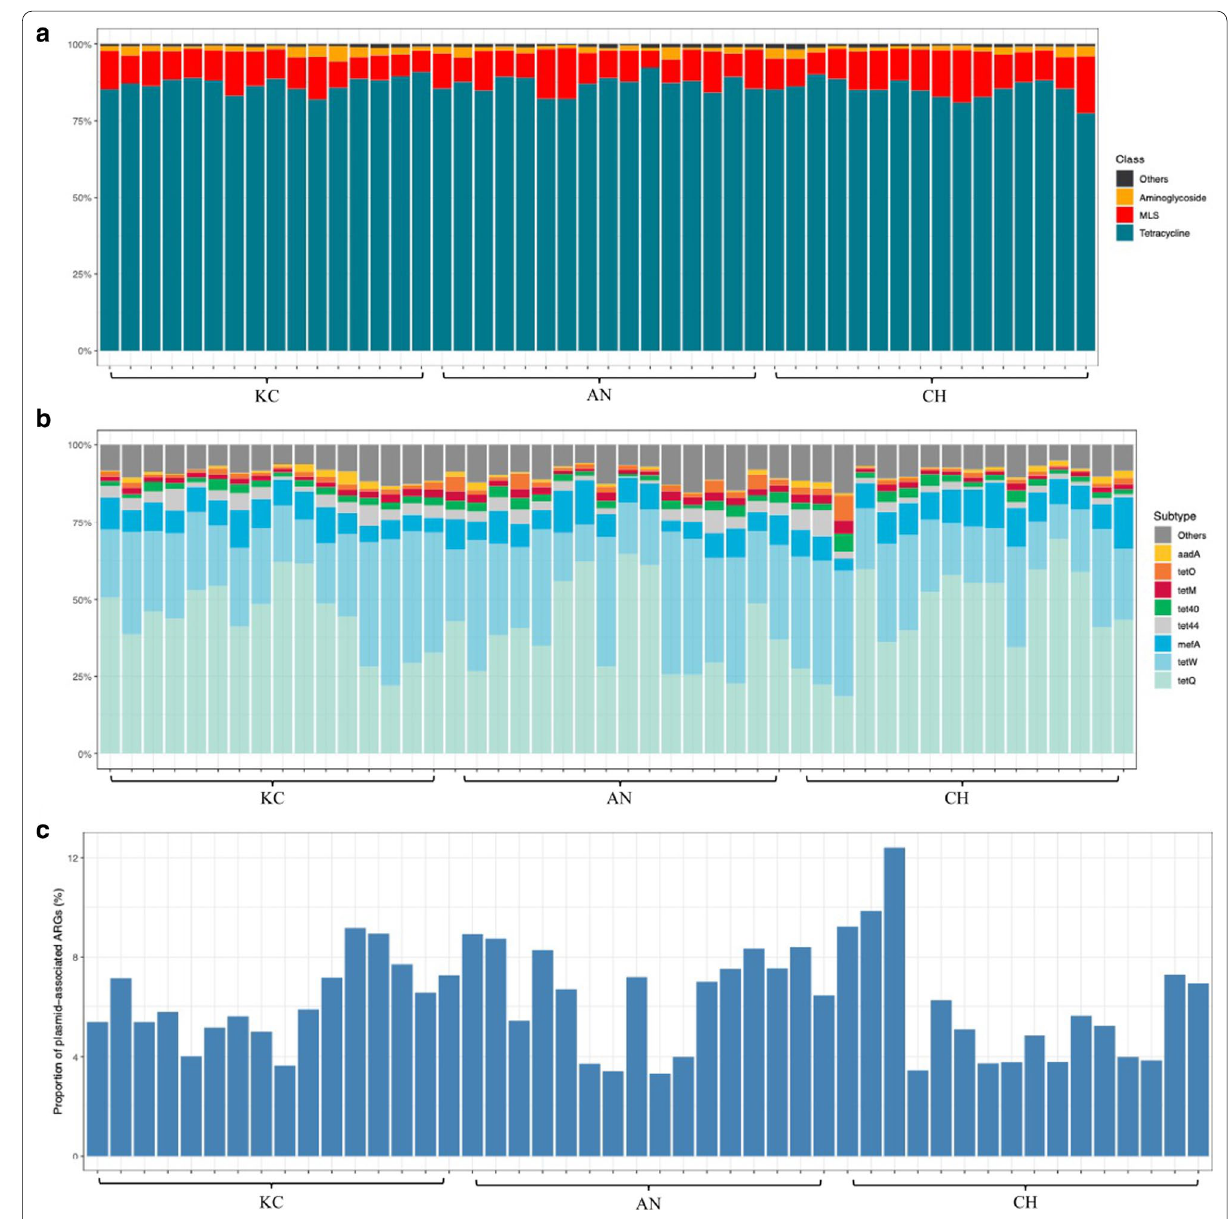
Fig. 1 Profiles of resistome in the rumen of 48 beef cattle. a The rumen resistome is predominant by ARGs belonging to tetracycline, MLS, and aminoglycoside classes, and ‘others’ include other 15 classes. b Proportion of 8 predominant ARGs and ‘others’ include other 179 individual ARGs. c Proportion of plasmid-associated ARGs in the total ARGs. ARG, antimicrobial resistant gene; MLS,